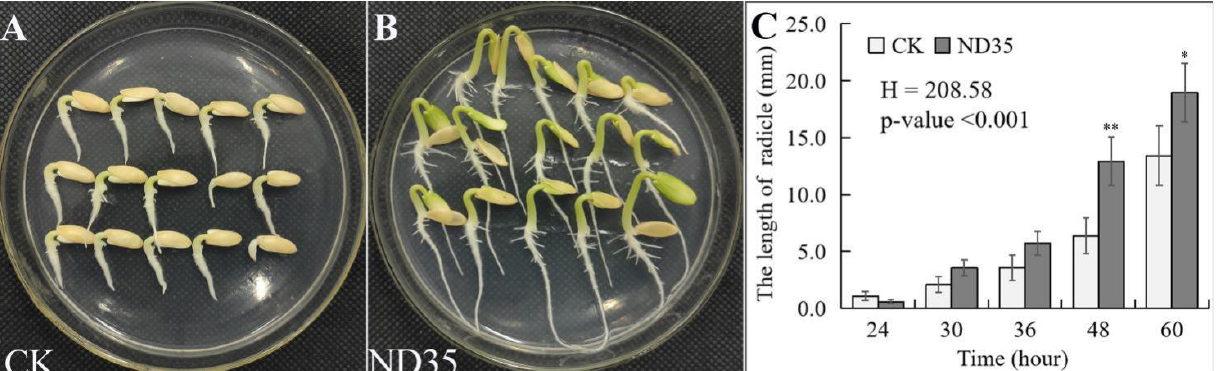
CK: The cucumber seeds treated with sterile water. The data in the table are mean ± SD. The different lowercase letters in the same column indicate significant differences ( p < 0.05).